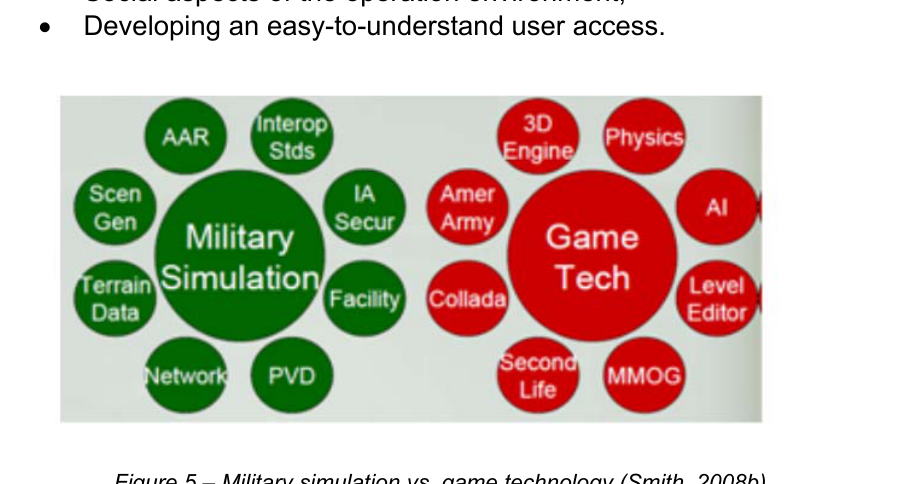
Figure 5 – Military simulation vs. game technology (Smith, 2008b) Рис . 5 – Взаимосвязь между военным моделированием и технологией игр